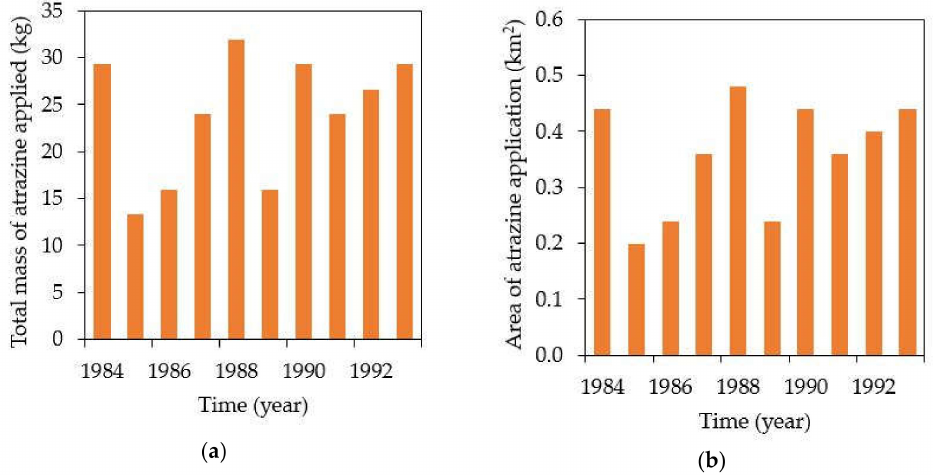
Figure 5. The total mass of applied atrazine ( a ) and the area of the atrazine application in the study area ( b ) from 1984 to